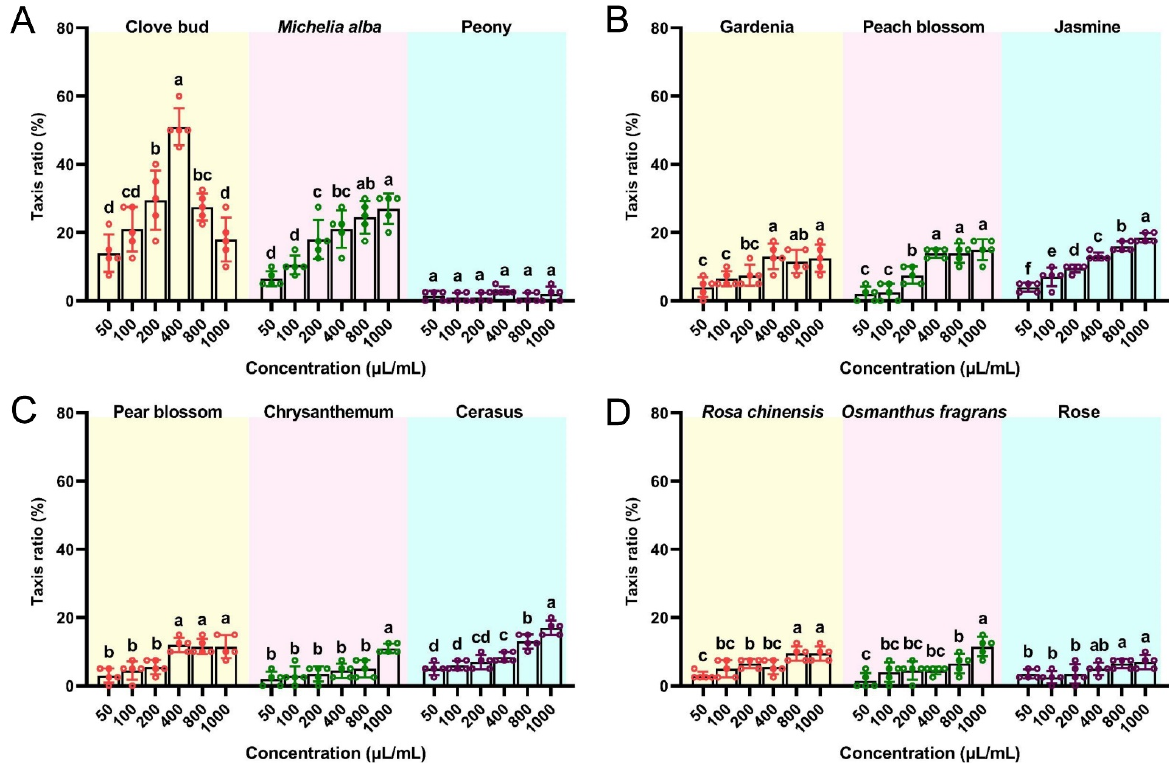
Figure 1. Behavioural response of Bactrocera dorsalis mature flies to flower ‐ derived essential oils (EOs). Attractant activity to mature flies was assessed using a trapping method for different con ‐ centrations of ( A ) clove bud, Michelia alba , and peony EOs; ( B ) gardenia, peach blossom, and jasmine EOs; ( C ) pear blossom, chrysanthemum, and cerasus EOs; and ( D ) Rosa chinensis , Osmanthus fra ‐ grans , and rose EOs. Each bar represents the mean ± SEM of five replicates. Different lowercase letters indicate significant differences (ANOVA, p < 0.05).